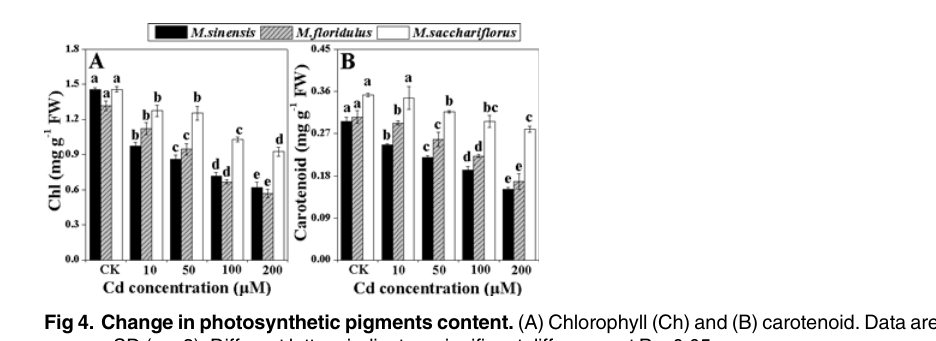
doi:10.1371/journal.pone.0153475.g004